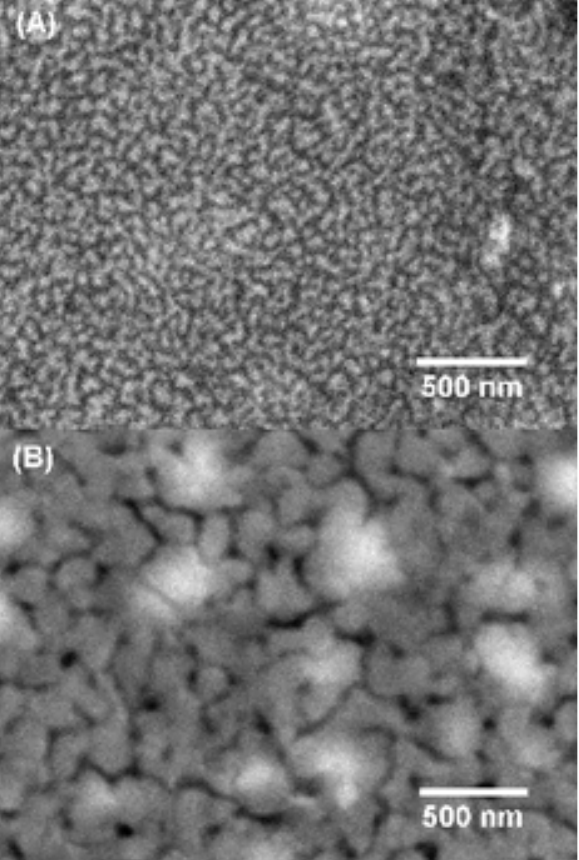
Figure 3. Scanning Electron Microscopy of the SBN thin film crystallized at 700 °C for 1 h (A) and at 700 °C for 5 h (B).